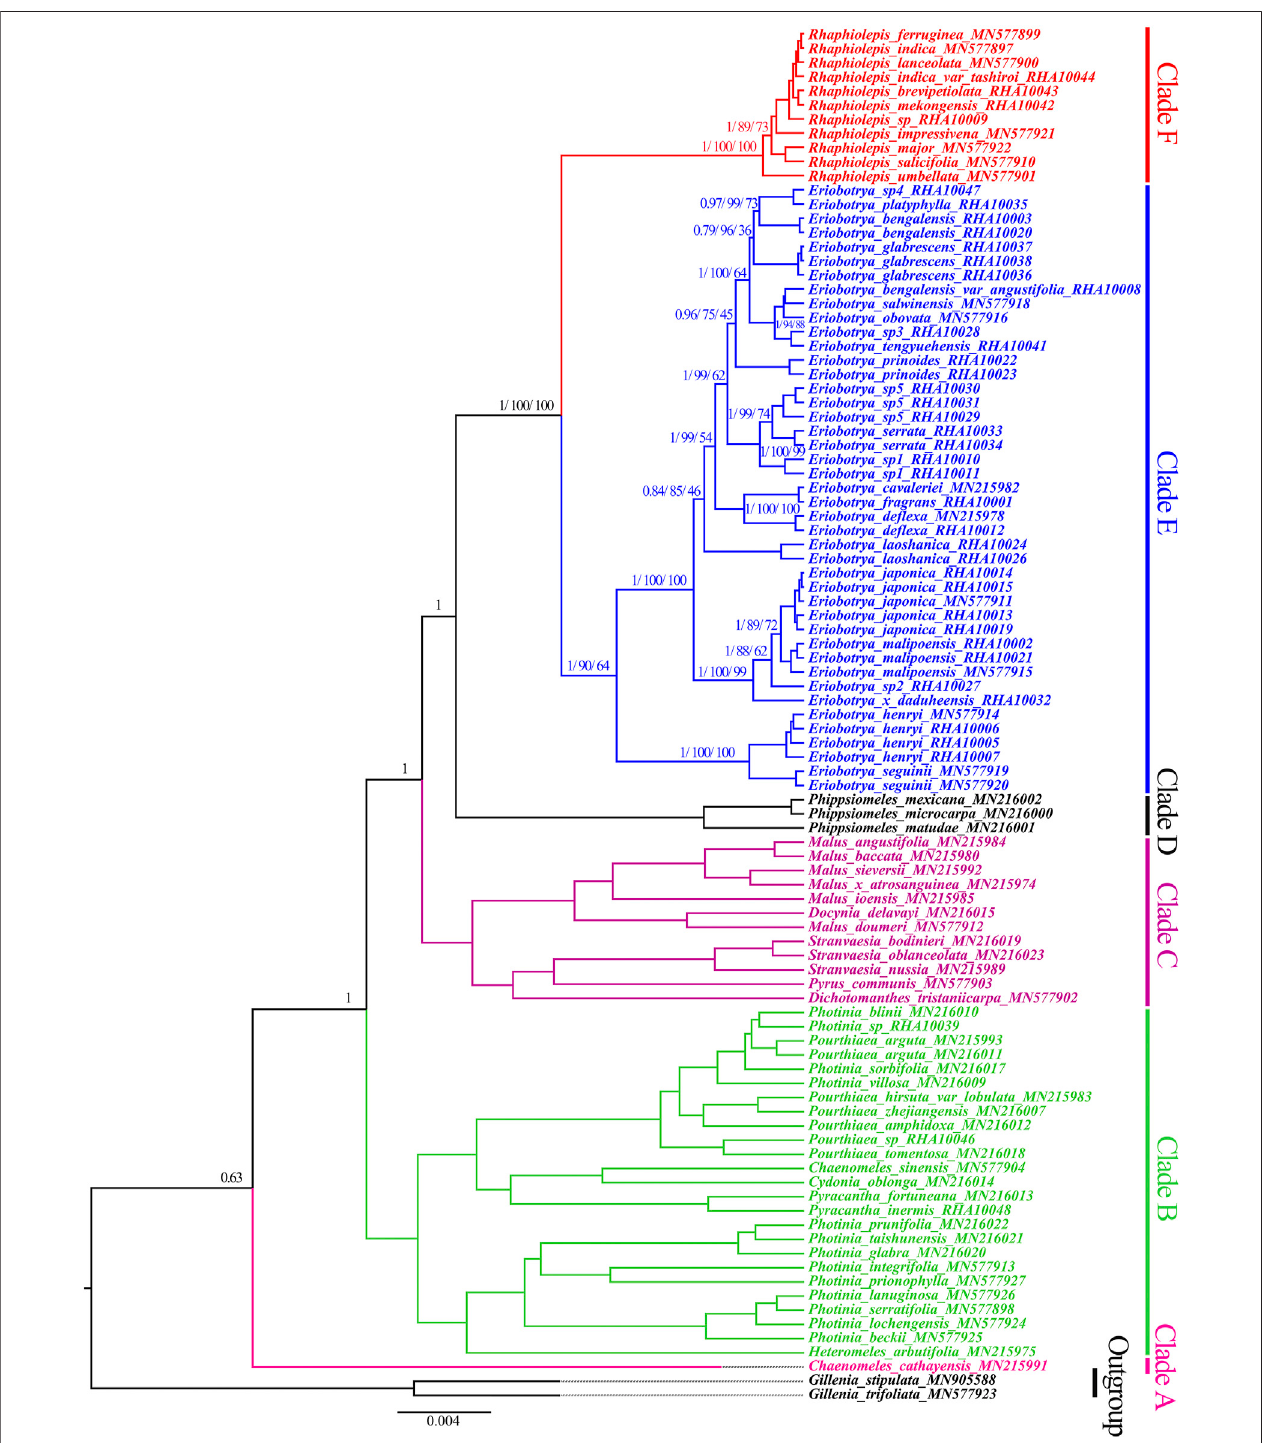
FIGURE 3 | Molecular phylogenetic tree of 97 taxa of Rosaceae based on nrDNA sequences using Bayesian inference. Numbers at each node are the Bayesian posteriorprobabilities/maximumlikelihoodbootstrapsupport/maximumparsimonybootstrapsupportvalues.DifferentbranchesaremarkedasCladeA,CladeB,Clade C, Clade D, Clade E, and Clade F. The tree was rooted using the nrDNA sequence of Gillenia trifoliate and G. stipulate as outgroups.